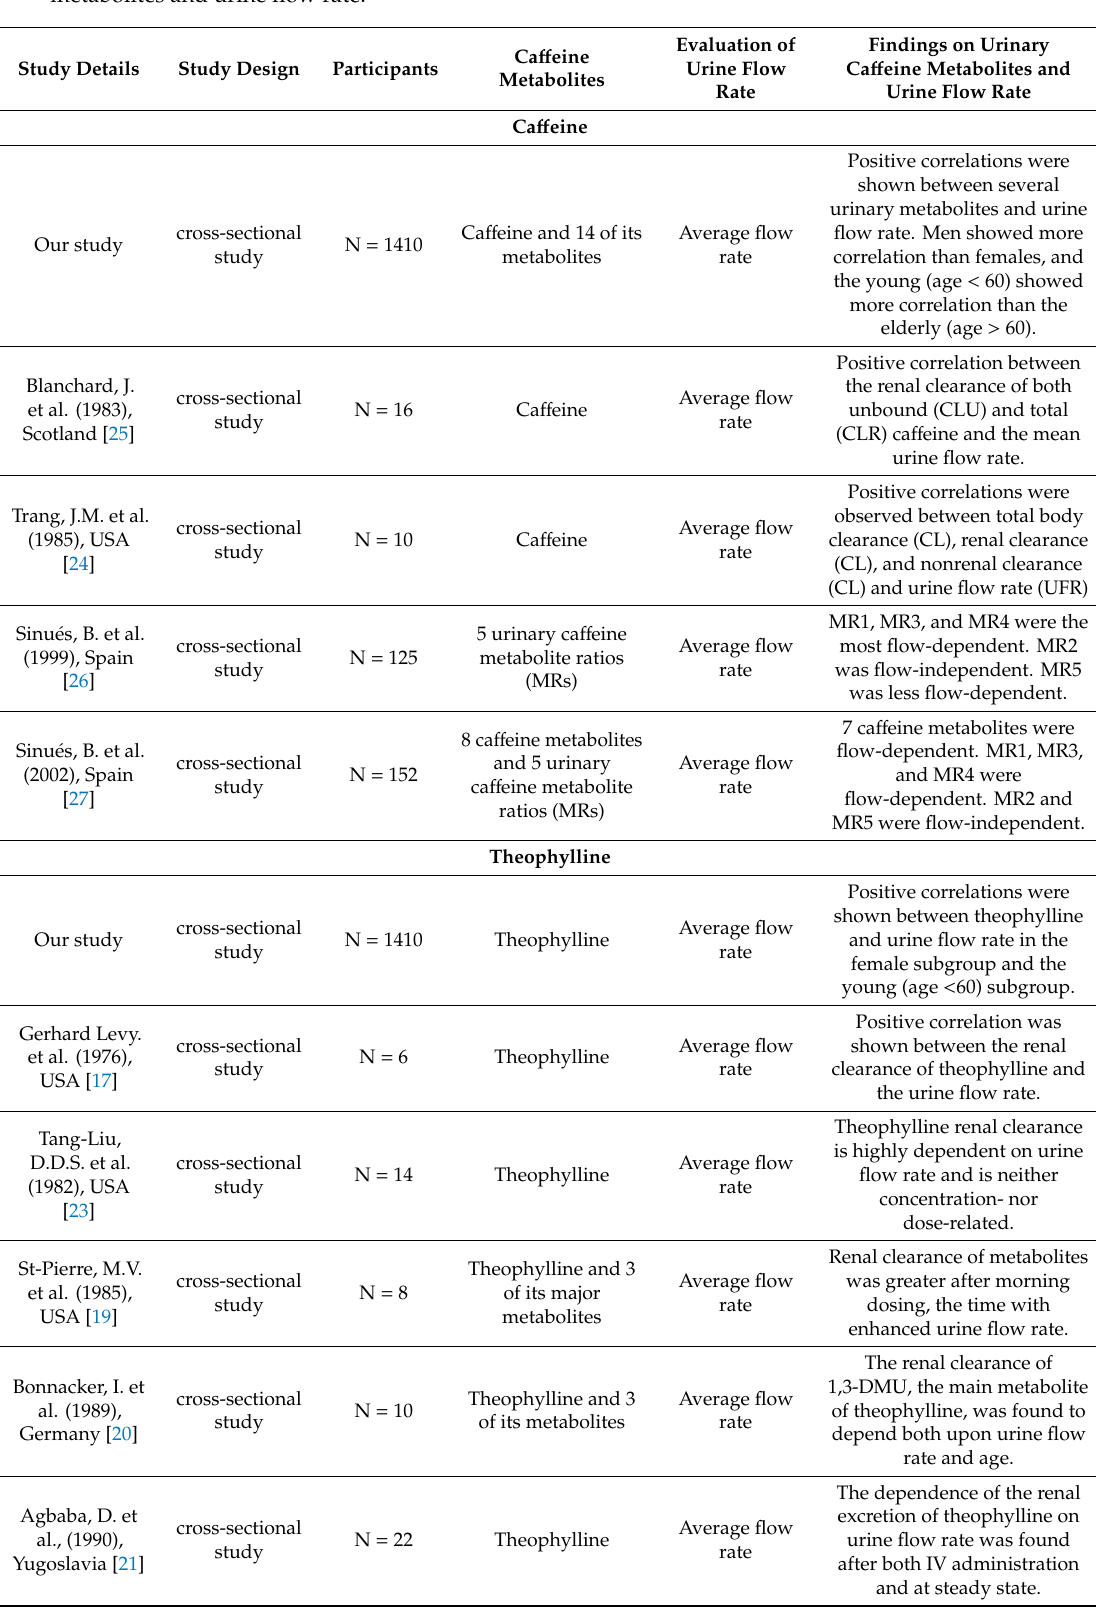
Table 5. Summary of the literature review findings on the association between urinary ca ff eine metabolites and urine flow